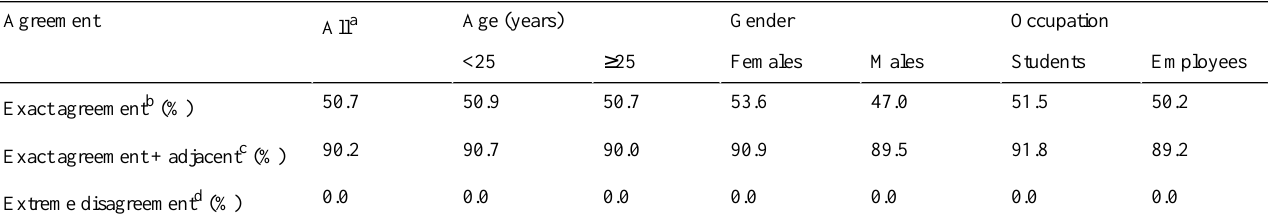
Table 4. Cross-classification analysis derived from the electronic 12-hour dietary recall app versus the food frequency questionnaire for categories of food group consumption and strata: age (years): <25 and ≥ 25; gender: females and males; and occupation: students and employees. Comparison of the electronic 12-hour dietary recall app versus food frequency questionnaire.